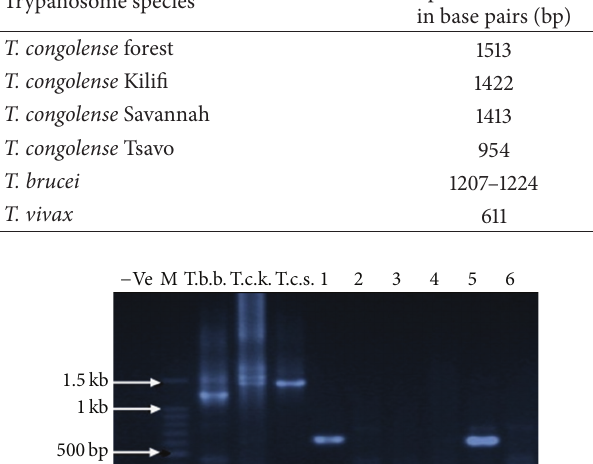
Table 2: Documented band sizes of trypanosome species [19]. Trypanosome species